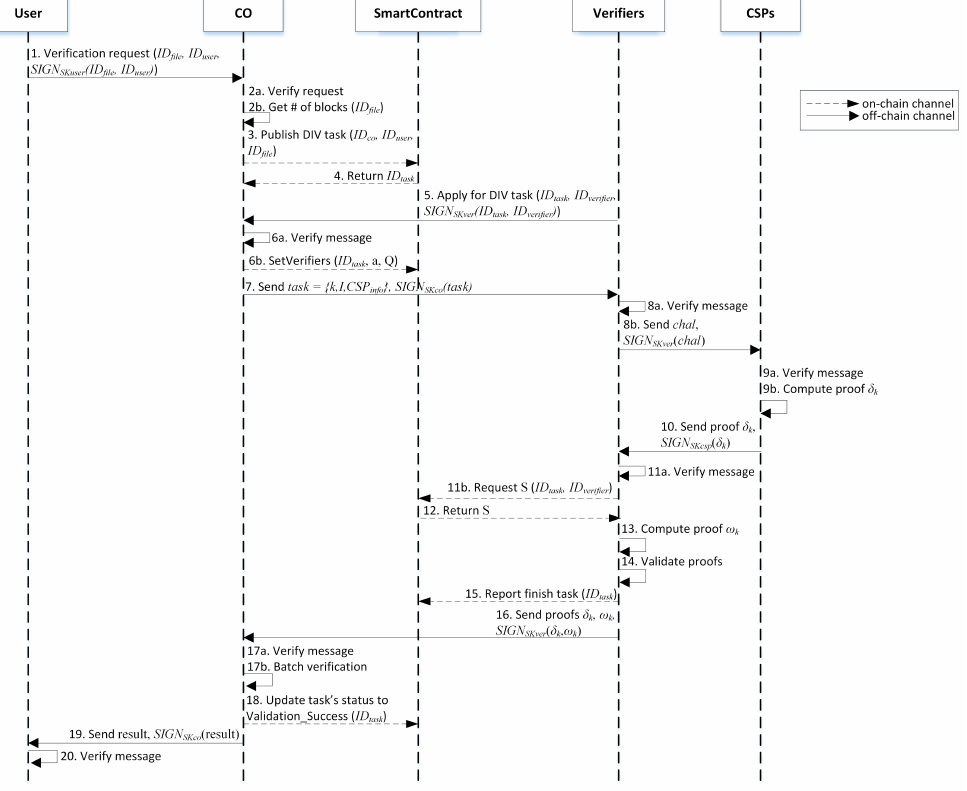
Figure 4. Data verification